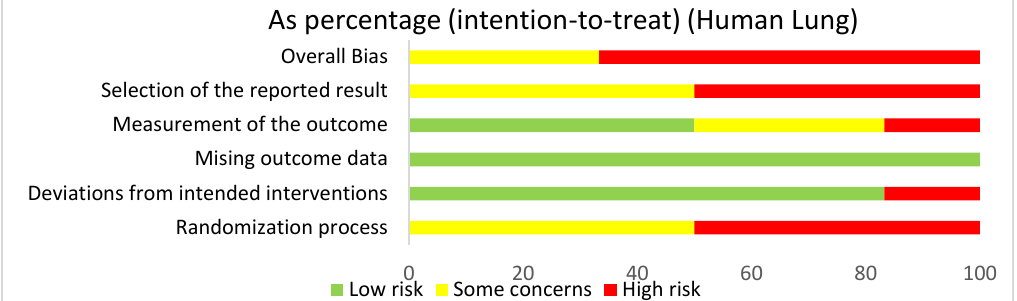
Figure 3. The overall risk of bias for all of the lung studies was a high risk of bias (56.8%) and some concerns (43.2%). The selection of the reported result had a high risk of bias (46.9%) and some concerns (53.1%). The measurement of the outcome had a high risk of bias (13%), some concerns (32.7%), and low risk of bias (54.3%). The missing outcome data domain had a low risk of bias (99.4%) and a high risk of bias (0.6%). Deviations from intended interventions had a low risk of bias (90.7%), some concerns (4.3%), and high risk of bias (4.9%). The randomization process had a high risk of bias (15.4%), some concerns (79%), and low risk of bias (5.6%).